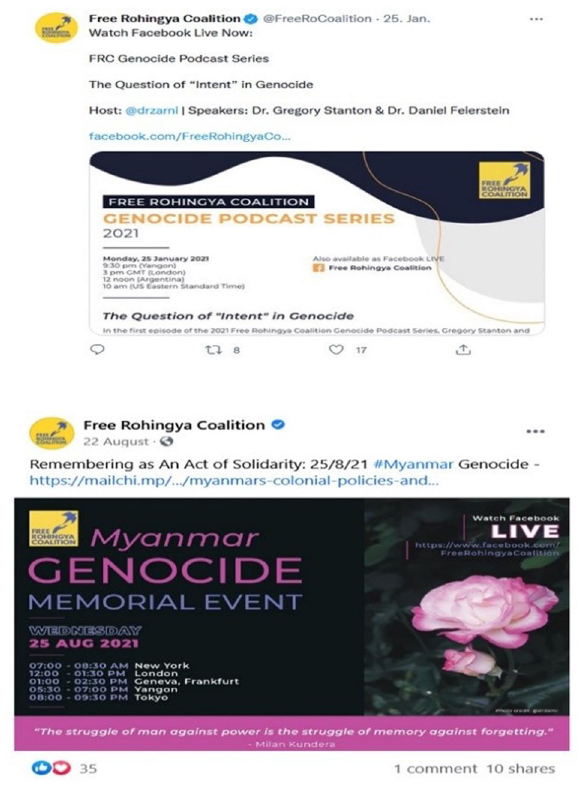
Fig. 6 Online seminars are used to internationalise the Rohingya plight. Rohingya diaspora platforms hosting webinars and podcasts on genocide